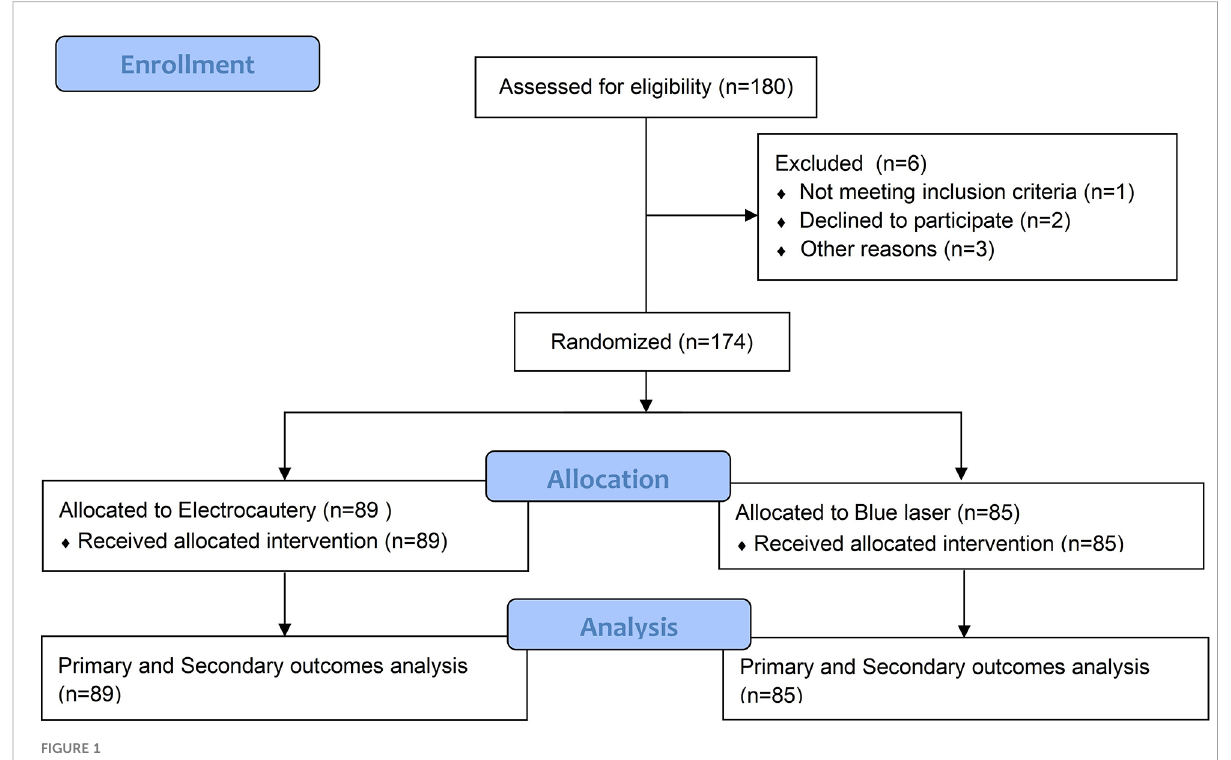
FIGURE 1 Patient selection process and exclusions.